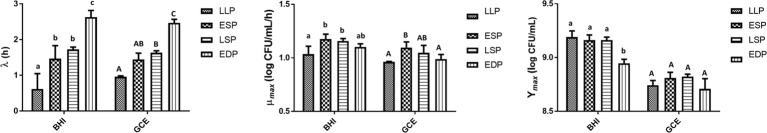
The lag time (λ), growth rate (μmax), and maximum growth (Ymax) of S. Typhimurium DT104 as a function of the previous life cycle phase, late log phase (LLP), early stationary phase (ESP), late stationary phase (LSP), and early death phase (EDP) in brain heart infusion broth (BHI) and ground chicken extract (GCE). Different lowercase and uppercase letters within a cluster of bars differed significantly (p < 0.05).